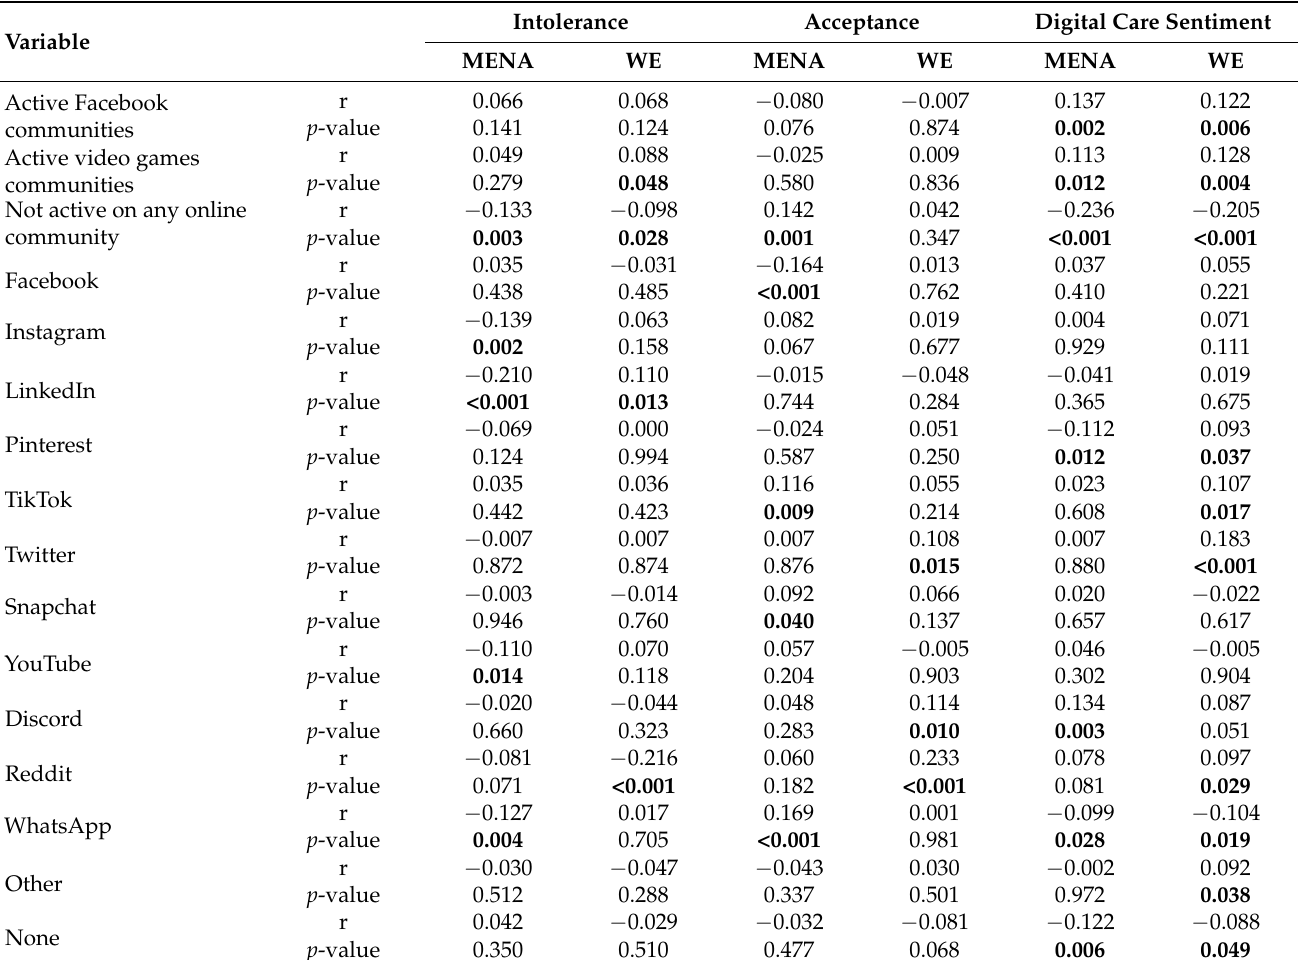
Table 6. Correlation between platforms, activity, and